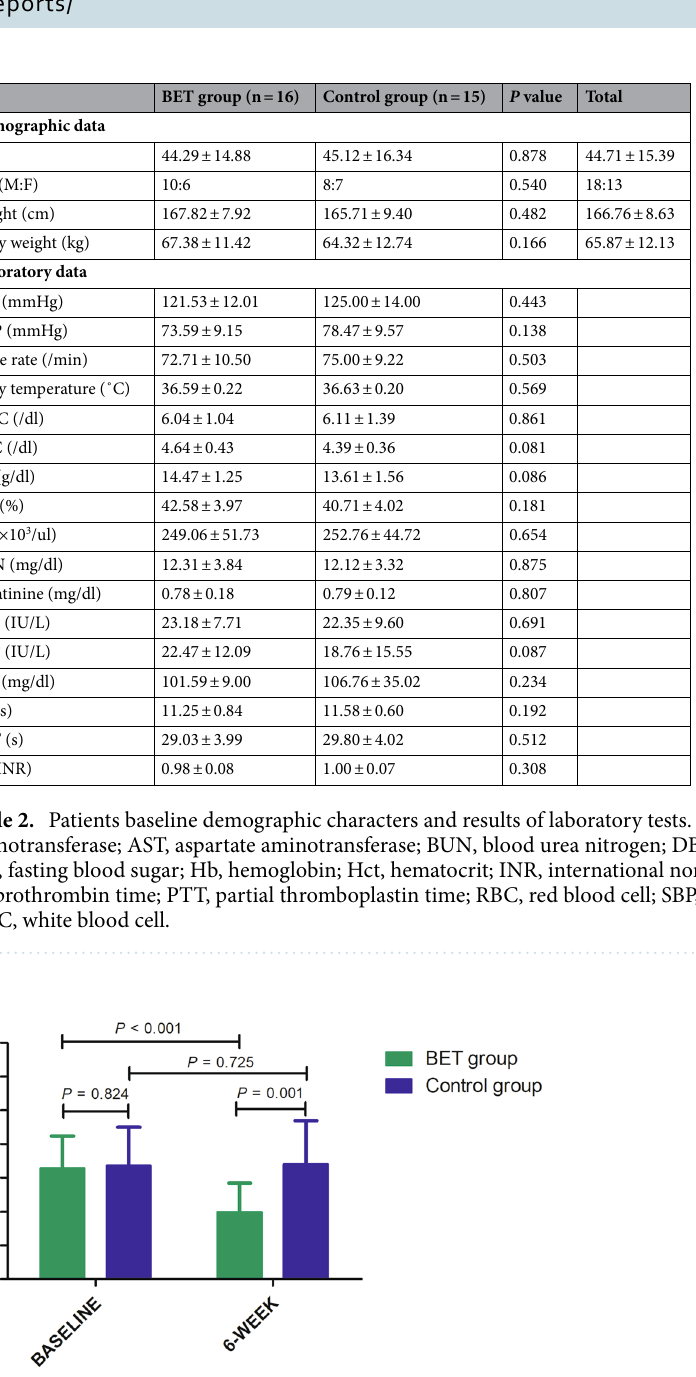
Figure 2. The average ETDQ-7 scores preoperatively and at 6 weeks